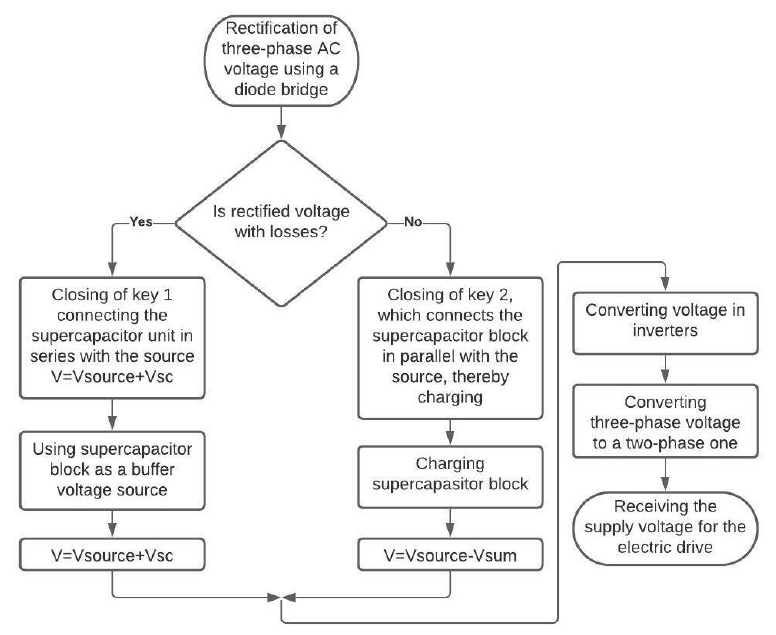
Figure 5. Algorithm of the control system operation for the buffer source of electricity.